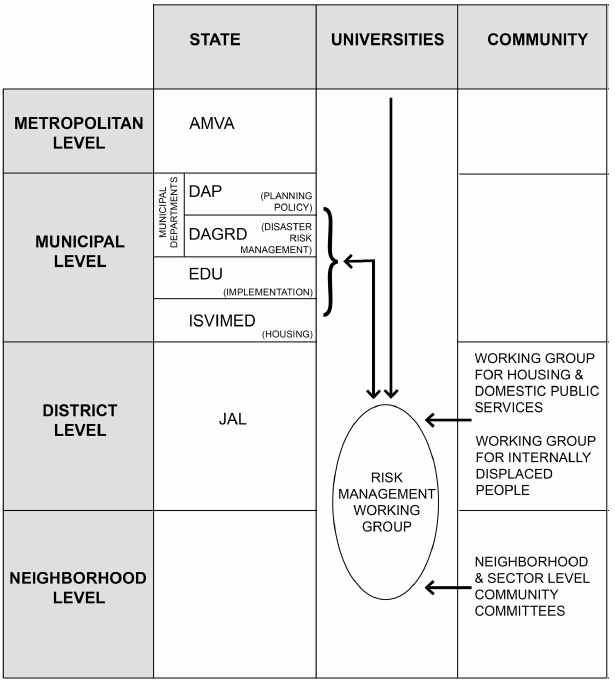
Fig. 6 . Community-local government risk management Working Group established through university-led facilitation. Source: the